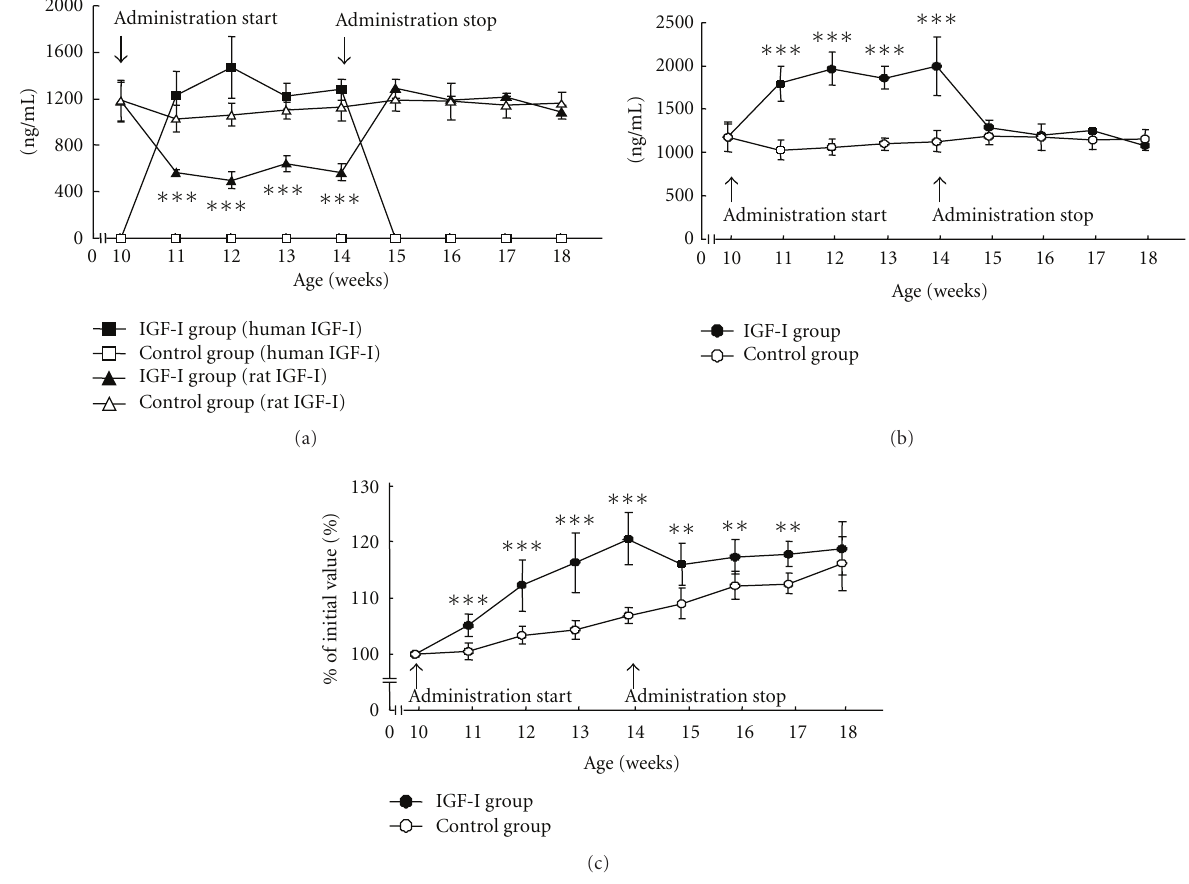
Figure 1: (a, b) Serum levels of human and rat IGF-I (a), and total IGF-I (b) during and after administration of human IGF-I ( ∗∗∗ P < 0 . 001 versus control). (c) Body weight, as a percentage of initial value in the same animal, during and after administration of human IGF-I ( ∗∗ P < 0 . 01, ∗∗∗ P < 0 . 001 versus control). In (a)–(c), data represent the mean ± SD of six rats, adapted from a previous report